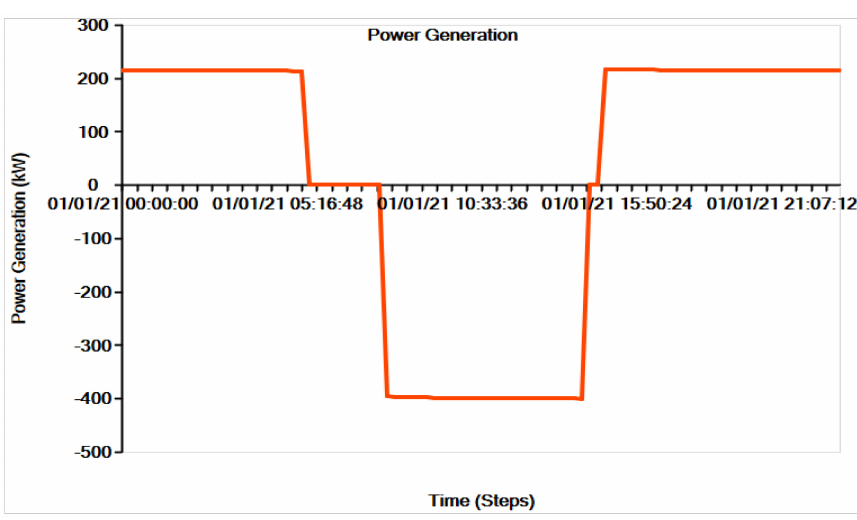
Figure 15. Lead–acid power generation profile.